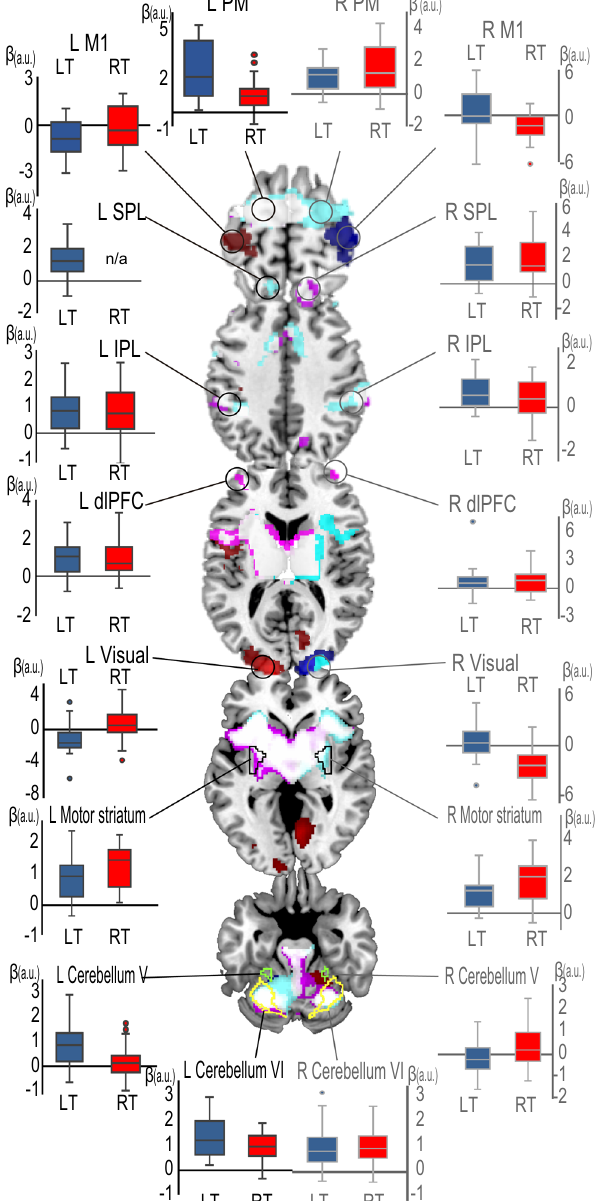
Fig. 2 Task-related signal changes for the BCI task compared with signals at rest. Red and blue areas denote BCI-related activity during right target (RT) and left target (LT) tasks, respectively, which differed signi fi cantly when comparing the two tasks. Magenta- and cyan-colored areas represent nonlateralized activity during RT and LT tasks, respectively, and white areas represent their overlap. PM premotor area, M1 primary motor area, SPL superior parietal lobule, IPL inferior parietal lobule, dlPFC dorsolateral prefrontal cortex, a.u. arbitrary units. The center lines of the boxplots indicate the medians, box limits indicate the lower and upper quartiles, the whiskers represent 1.5 times interquartile range, and circles indicate the miss trials during the BCI control period ( t (21) = 2.38, P = 0.027,